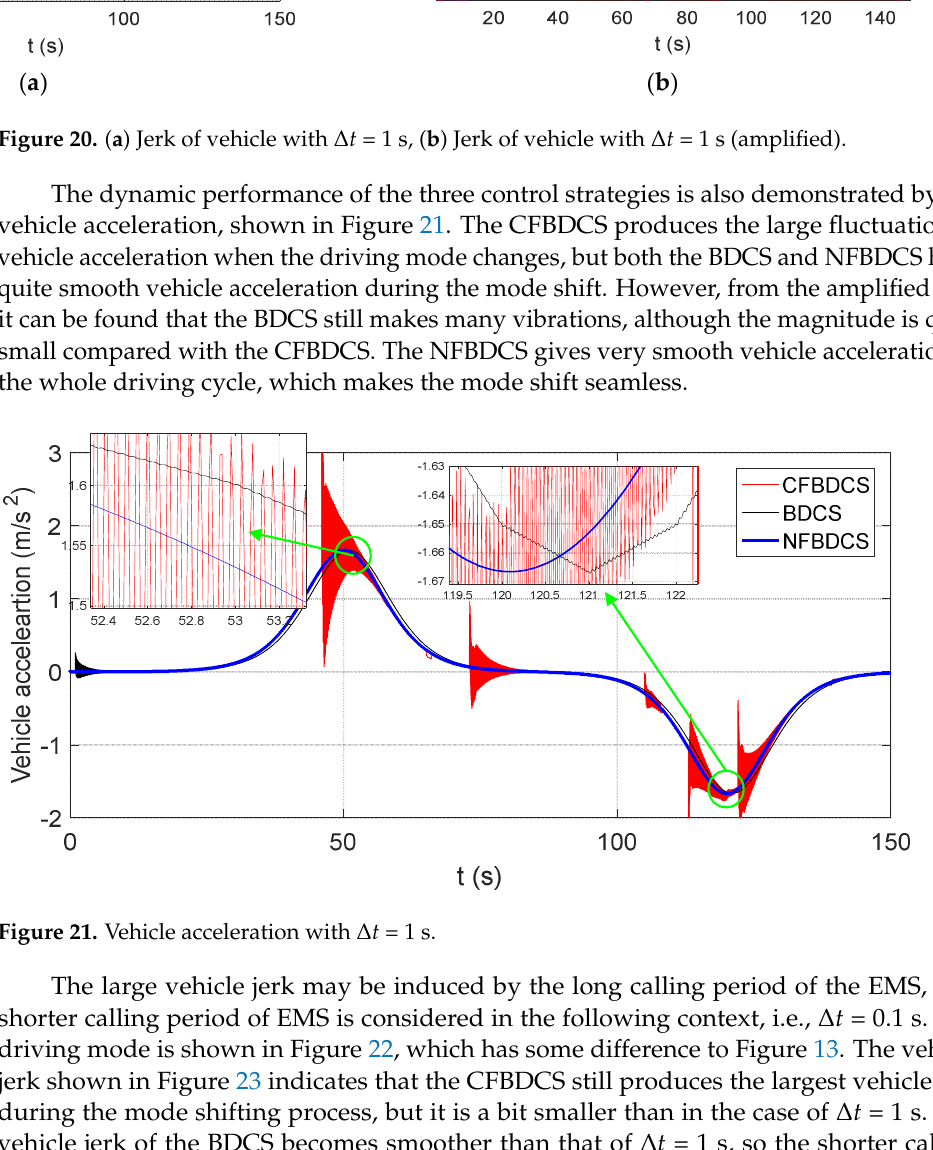
Figure 22. Vehicle driving mode with Δ t = 0.1 s.